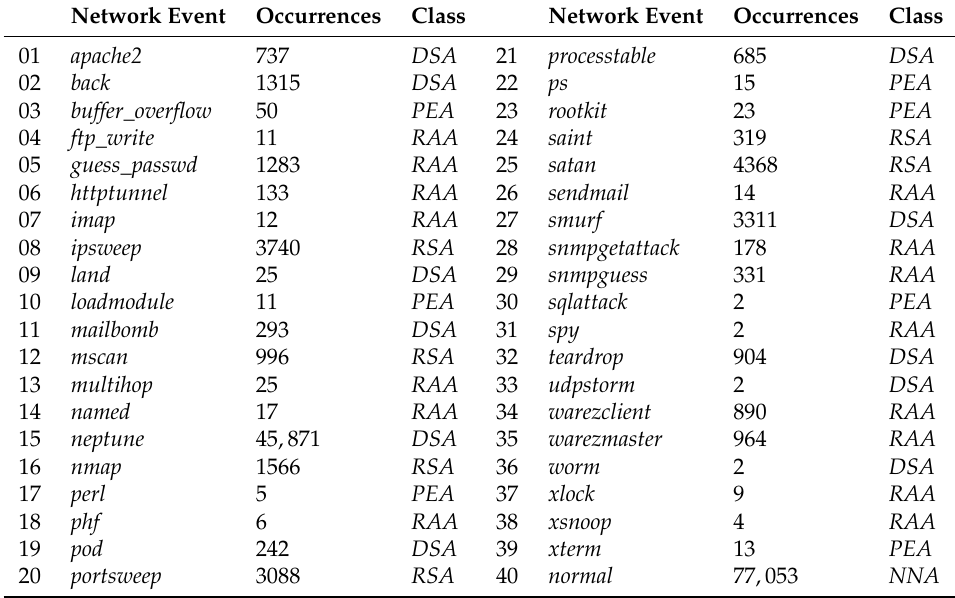
Table 7. Distribution of dataset events.